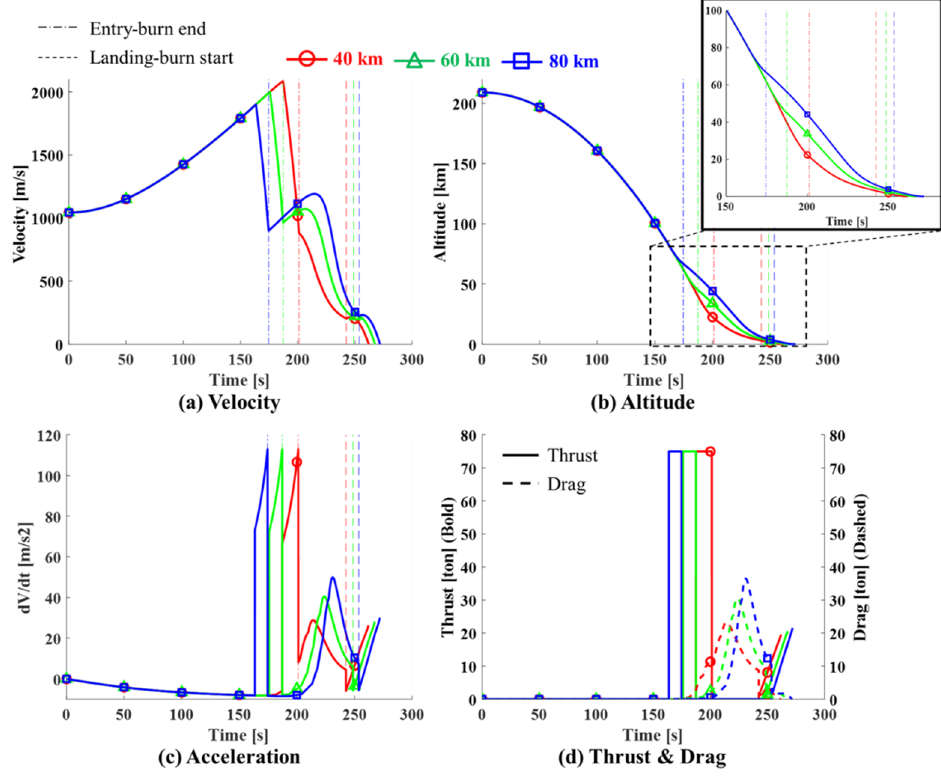
Figure 18. Results obtained by entry-burn starting altitude variation. ( a )Velocity; ( b ) Altitude; ( c ) Acceleration rate; ( d ) Thrust and Drag. ( c ) Acceleration rate; ( d ) Thrust and